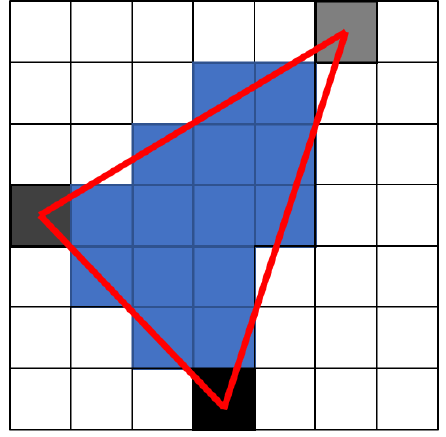
Figure 6. Triangle depth rasterizing.